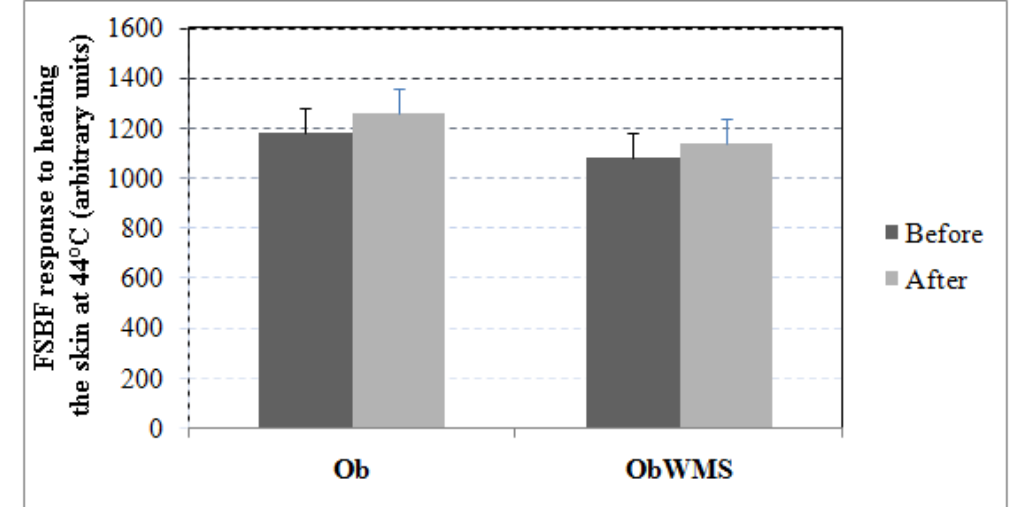
Figure 3. Forearm skin blood flow (FSBF) response to heating the skin at 44 ◦ C (expressed as arbitrary units) observed before and after physical training in obese with and without metabolic syndrome. Elevation of the skin temperature at 44 ◦ C, an endothelium-independent vasodilator, did not affect the forearm skin blood flow response of the groups significantly. Ob: obese without metabolic syndrome, ObWMS: obese with metabolic syndrome.